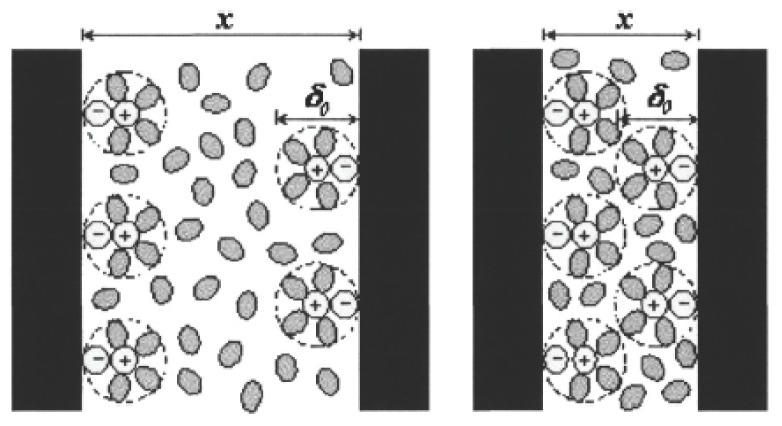
Schematic picture for the origin of hydration forces according to the model of Paunov et al. (Reproduced by permission of Elsevier [335]).